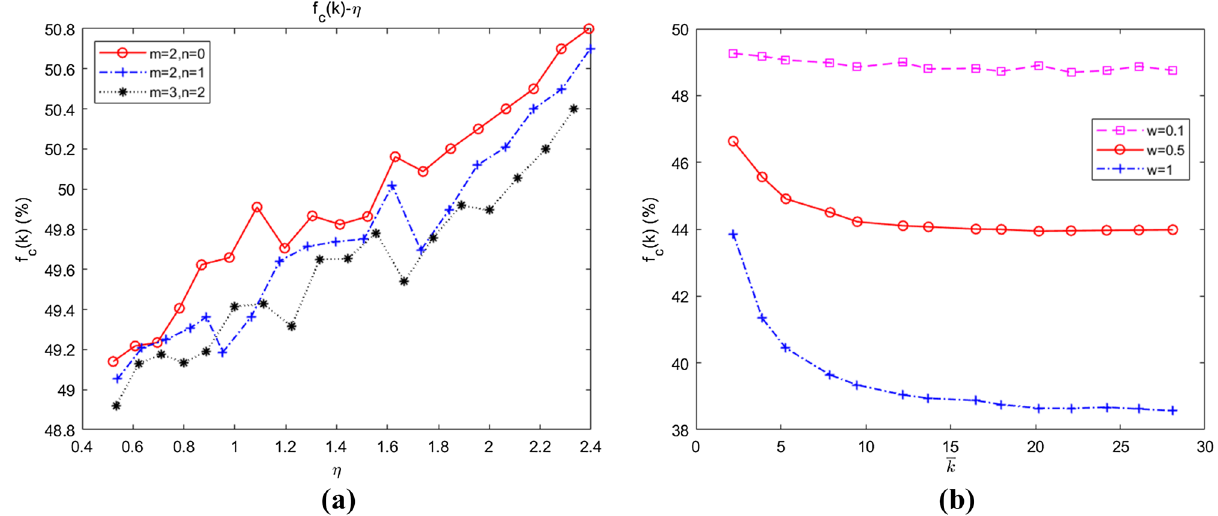
Figure 7. ( a ) Dependence of the emergence of collaboration on η ; ( b ) dependence of the emergence of collaboration on average